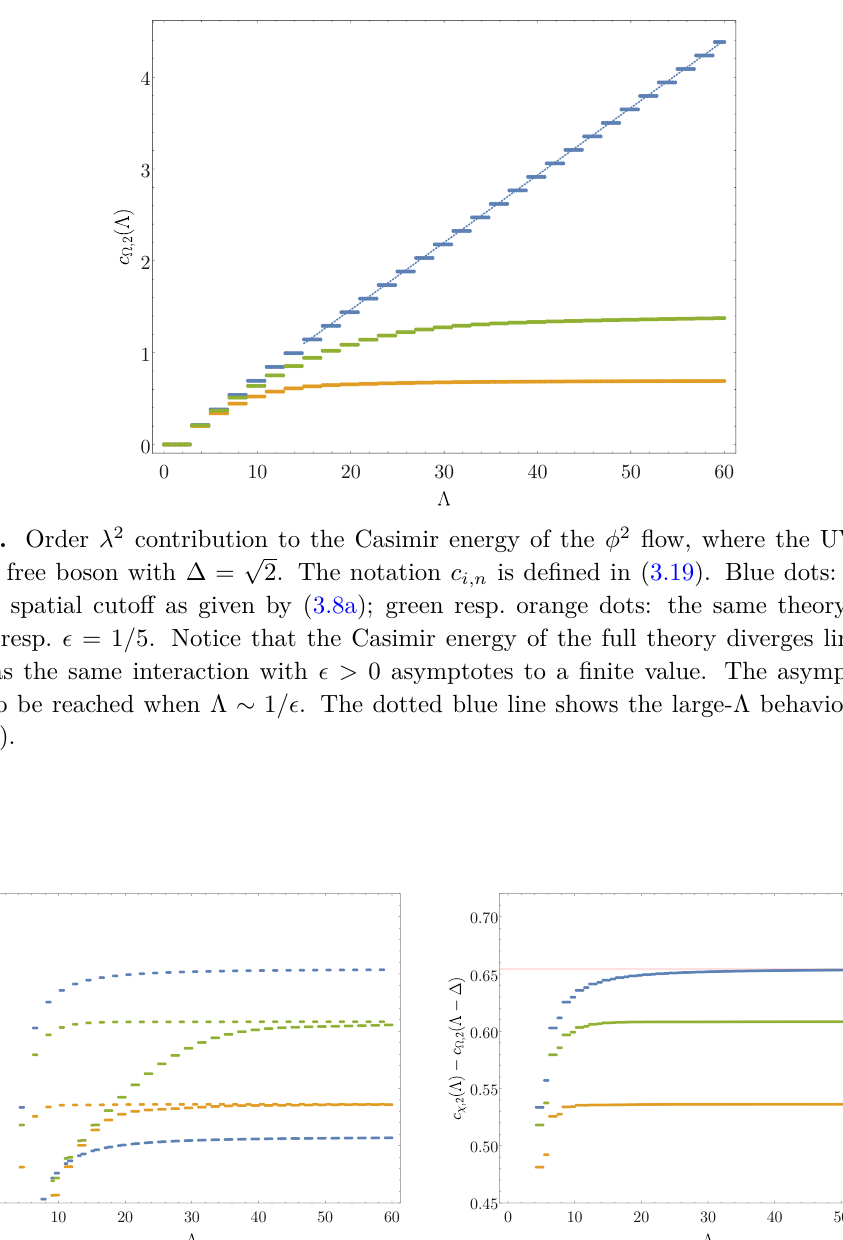
Figure 4. Order λ 2 contribution to the energy gap of the massive boson with ∆ = the naive prescription (3.10) (left) and the prescription (3.1) (right). The unregulated theory is shown in blue; the same theory regulated with (cid:15) = 1 / 10 (resp. (cid:15) = 1 / 5 ) are shown in green (orange). For (cid:15) > 0 the two prescriptions agree as Λ → ∞ . However, there are significant deviations (oscillations) for Λ . ( few ) /(cid:15) . In particular, for (cid:15) = 0 , only the prescription (3.1) converges to the exact result shown as a solid red line; there are O(1) oscillations that persist up to arbitrarily large cutoff if the naive prescription is